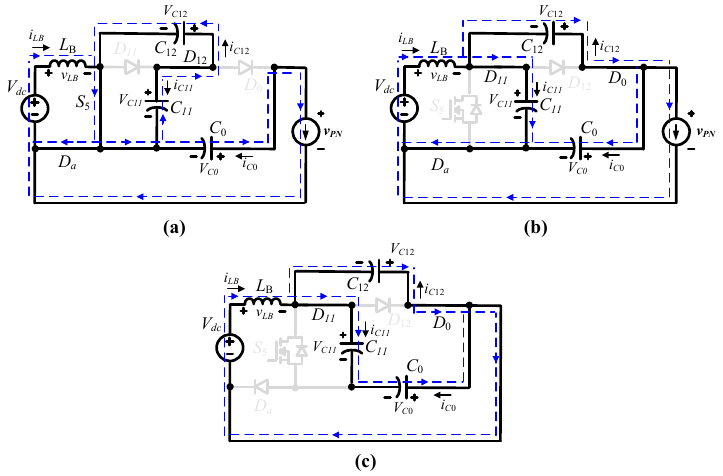
Figure 2. Operating states of proposed single-VMC-qSBI. ( a ) Non-ST state 1, ( b ) non-ST state 2, and ( c ) ST state.